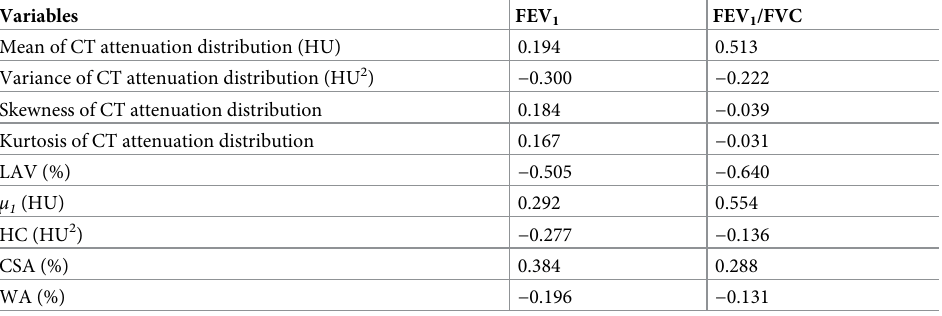
Table 2. Pearson’s correlation coefficients between the quantitative evaluation of COPD and PFT